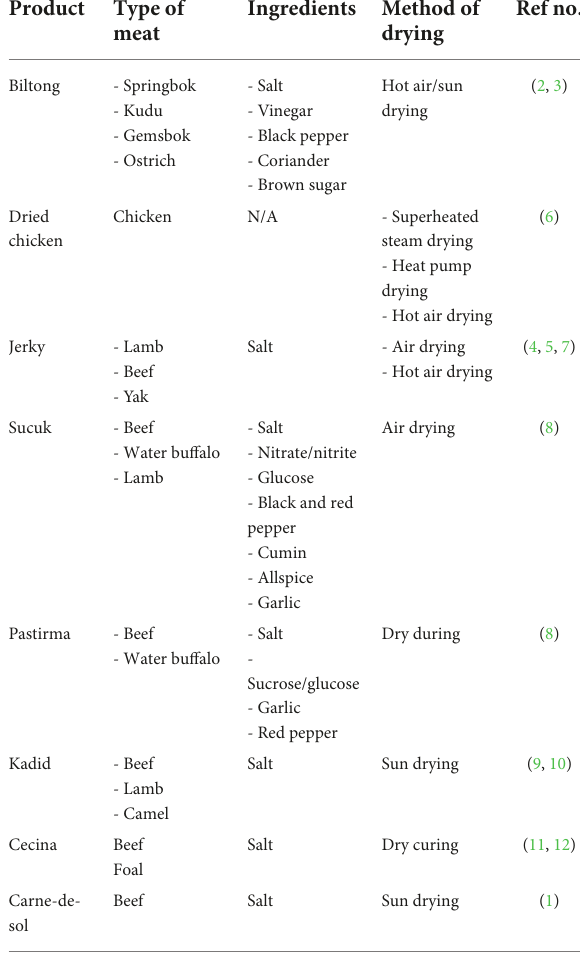
TABLE 1 Summary of the type of dried meat according to their drying